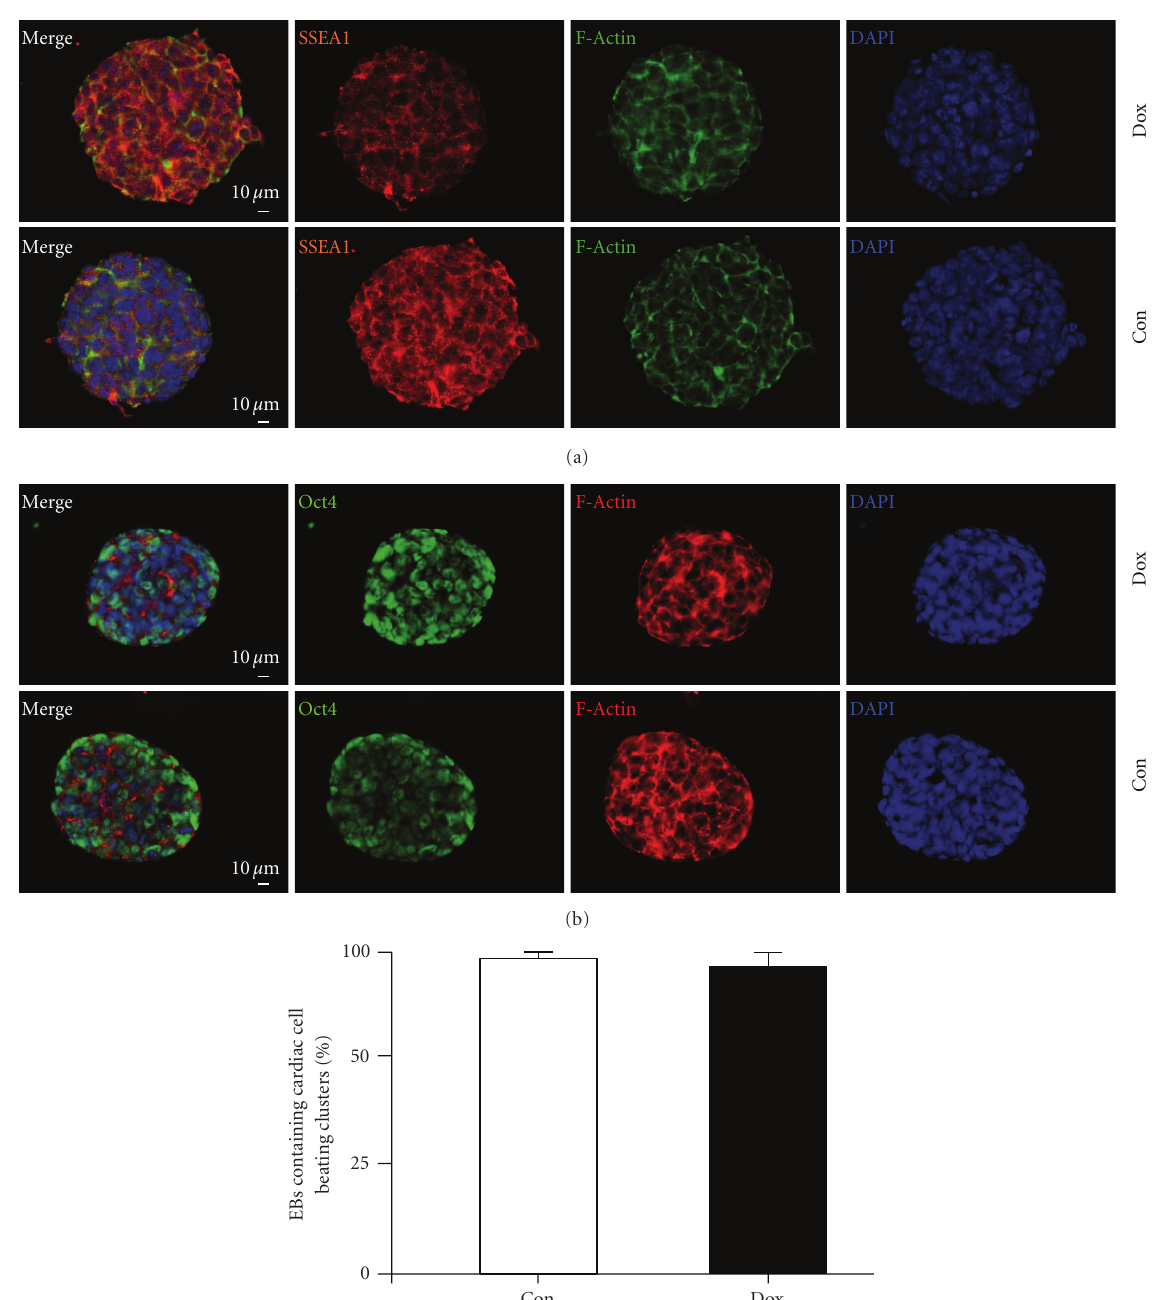
Figure 1: E ff ects of doxycycline treatment on A2lox.cre ES cells. (a, b) SSEA-1 (a) and Oct4 (b) staining upon 3 days of treatment with 1 μ g/mL of doxycycline revealed no di ff erence in expression levels. (c) EBs were plated, and the percentage of EBs containing cardiac cell beating clusters was determined in dox-treated versus untreated cultures on day 10 after EB plating on day